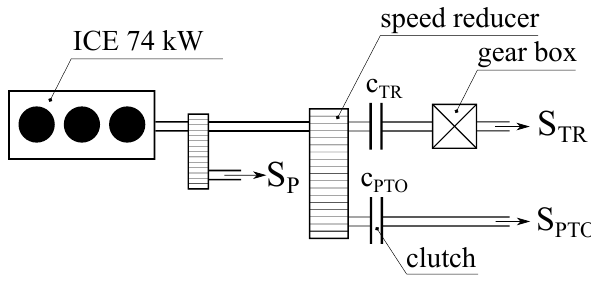
Figure 2. Traditional powertrain architecture powered by the Internal Combustion Engine